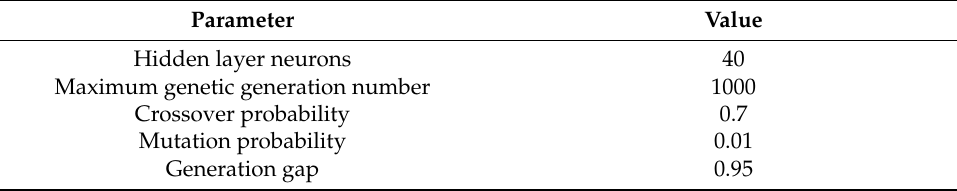
Figure 4. Algorithm flow chart of GA–ELM model. Table 2. Parameter settings of the GA–ELM model.